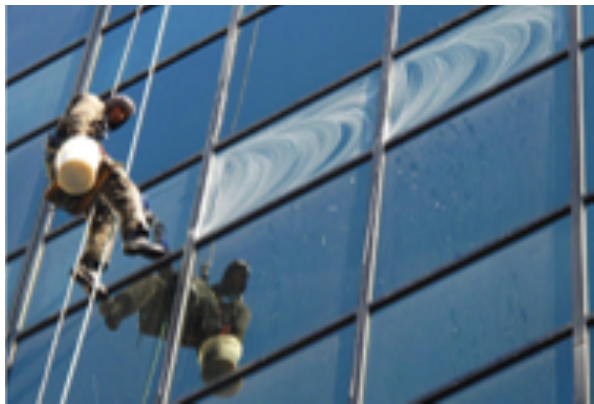
Figure 1. Workers cleaning the glass façade